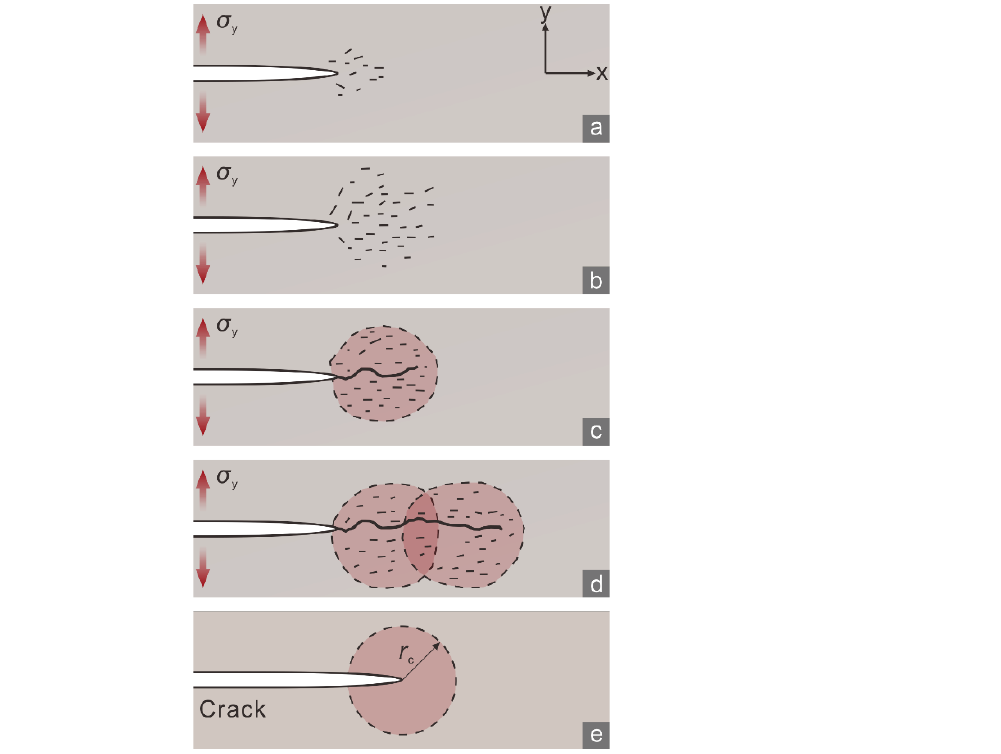
Figure 1. ( a ‒ d ) Formation of a fracture process zone (FPZ), shaded in red, and the propagation of macro fractures under the tensile stress σ y (denoted by red arrows). ( e ) Schematic of an FPZ with the size r c .